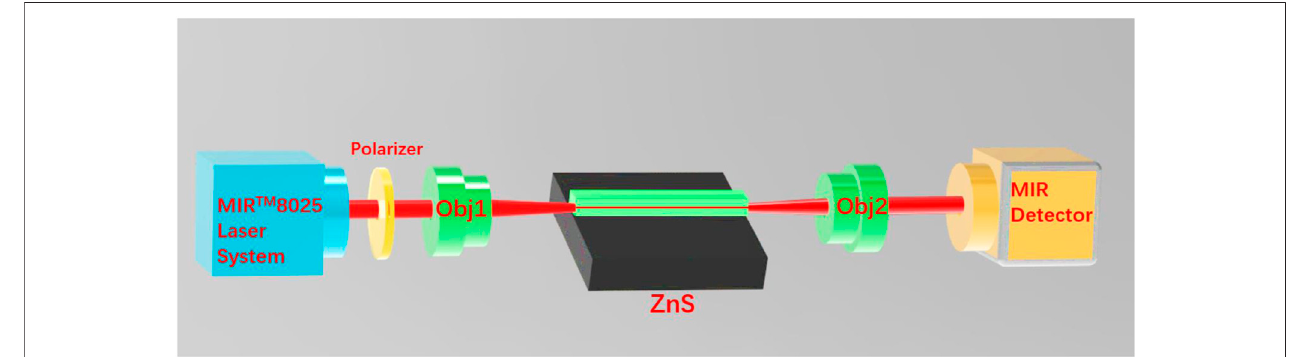
FIGURE 2 | Schematic diagram of end face coupling system of ZnS crystal ridge optical waveguides.